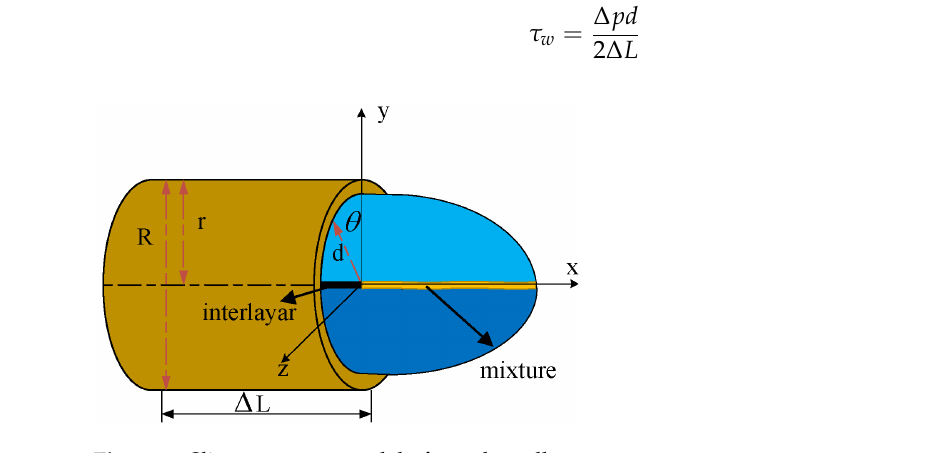
Figure 2. Slip parameter model of nozzle wall.